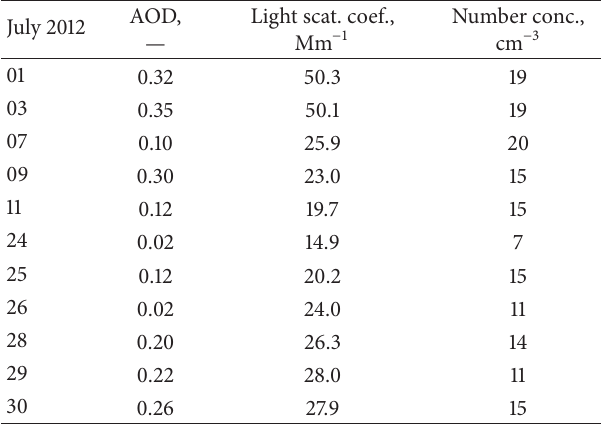
Table 1: The comparison of the aerosol optical depth, the light scattering coefficient (at 550 nm), and the particle number concen- > 0.5 𝜇 m) averaged tration ( 𝐷 pa